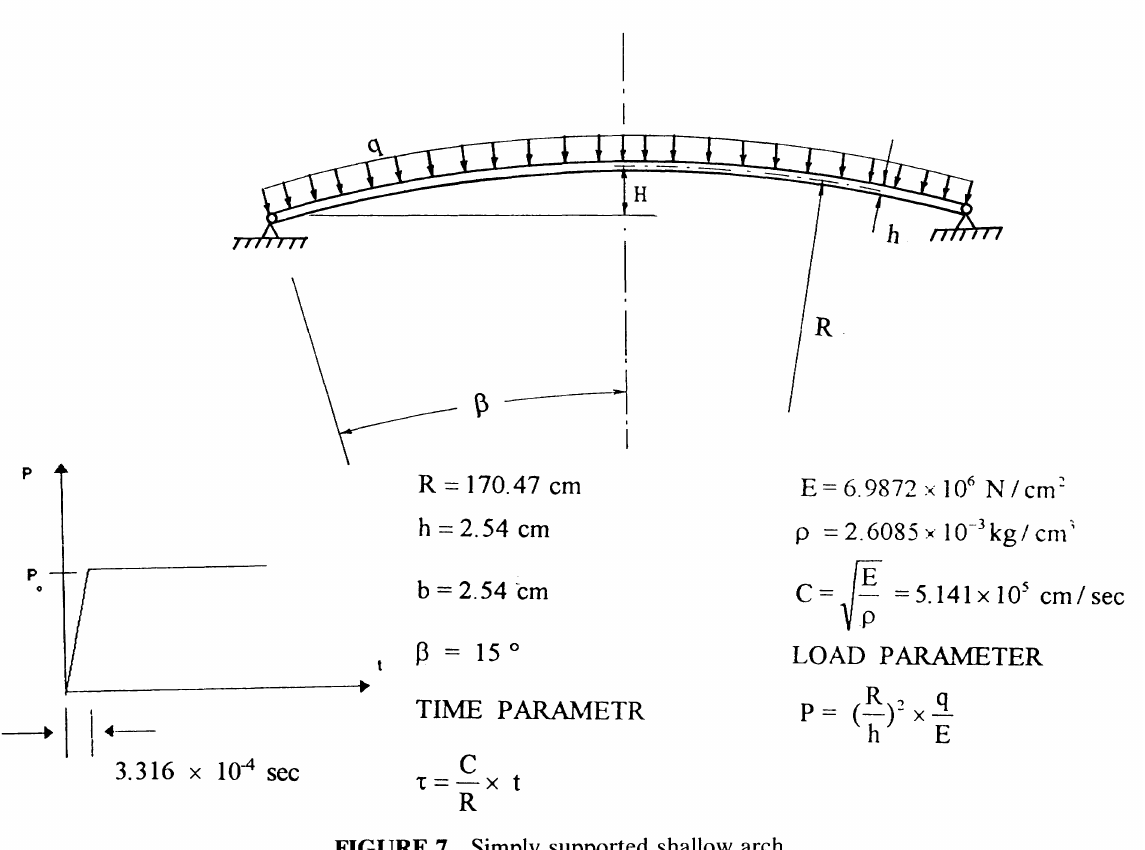
FIGURE 7 Simply supported shallow